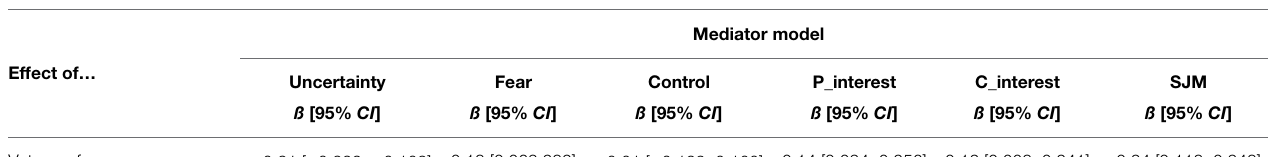
TABLE 6 | Direct effects of voter preference and motives on support for Trump (Study